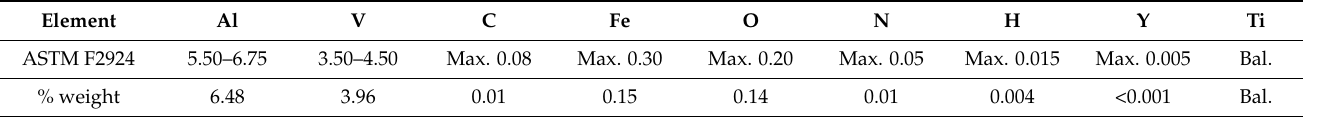
Figure 2. Ti–6Al–4V spherical powder morphology: ( a ) 100×; ( b ) 400× . As indicated by Liu and Shin [10], a non-melted powder sphere is the shape that minimizes stress concentration factors as opposed to acicular particles, which are more frequently present in conventional casting processes. Table 2 presents the powder’s chemical composition (% by weight) as given by the manufacturer and obtained with the ASTM F2924 standard. Table 2. Chemical composition (% by weight) of the Ti–6Al–4V powder as given by the manufac- turer.